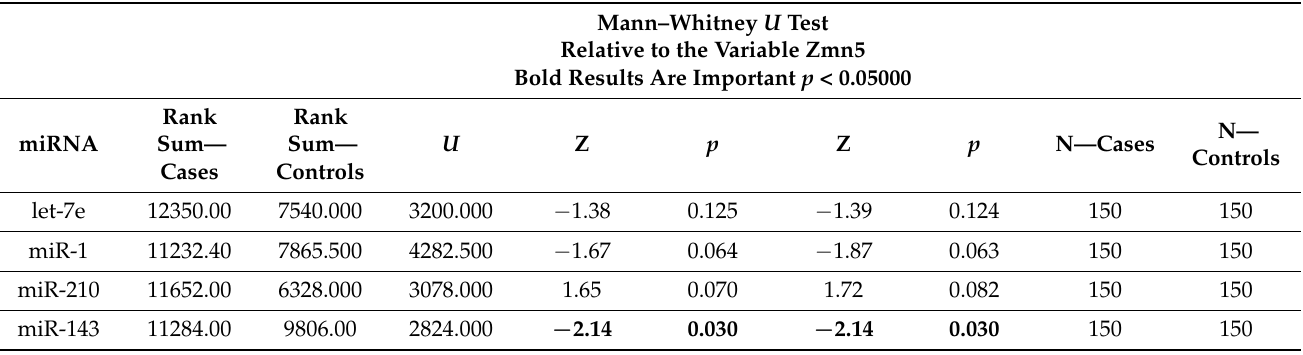
Table 5. Correlation of expressions of the studied miRNA in patients and controls.